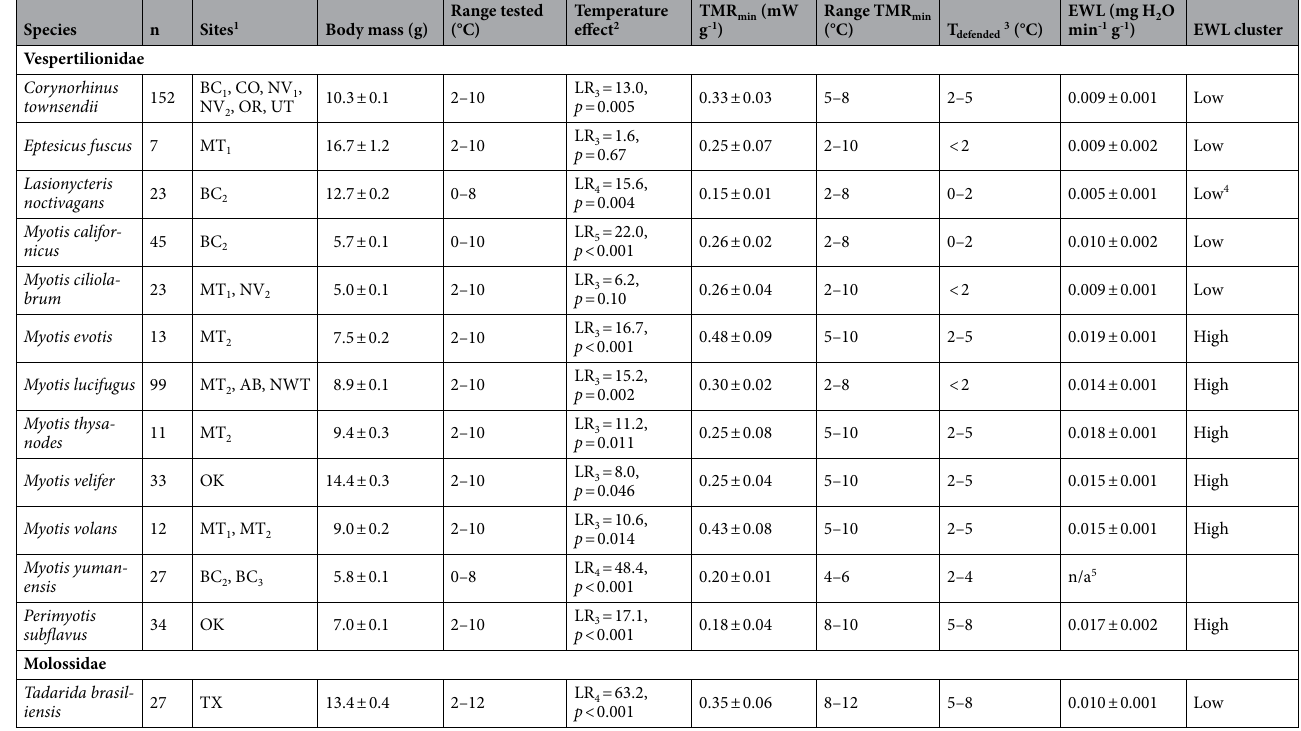
Table 1. We collected data from 13 species of hibernating bats, including metabolic rate and evaporative water loss. Torpid metabolic rate (TMR) varied across temperatures (Temperature Effect column) and the range of temperatures at which the minimum torpid metabolic rate (TMR min ) was recorded varied among species. Within that range of temperatures, TMR min did not vary among species, but species were divided into high evaporative water loss (EWL) and low EWL clusters (see Fig. 3). Values reported as mean ± standard error. 1 Subscripts identify different sites in states or provinces with multiple sites. 2 Effect of temperature on metabolic rate. LR = likelihood ratio with degrees of freedom indicated in subscript. 3 Where metabolic rate did not increase at coldest temperature tested, T defended can only be determined as less than the lowest temperature tested. Otherwise T defended is between the range of temperatures indicated. 4 L. noctivagans may represent a third cluster with lower EWL (see Fig. 3b), but to be conservative we present only two clusters here. 5 EWL was not measured for Myotis